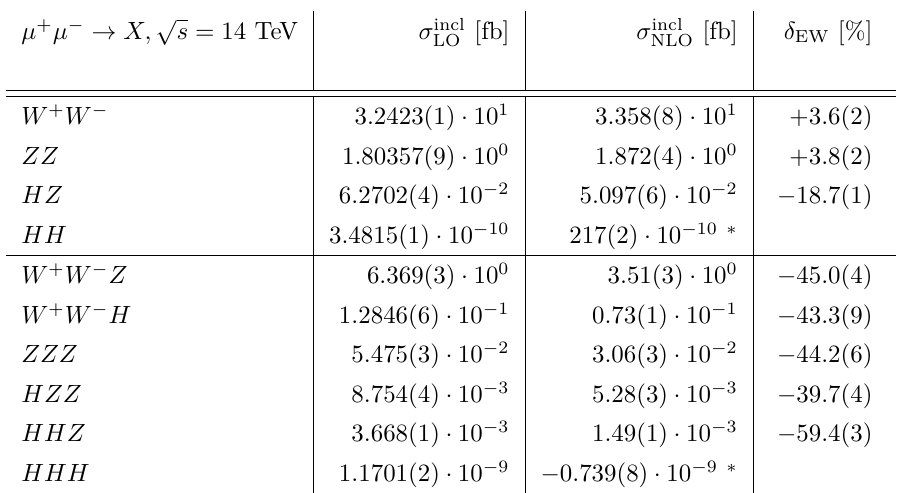
Table 3 . Total inclusive cross sections at LO and NLO with corresponding relative correction δ EW √ for di- and tri-boson production at s = 14 TeV. For (*), with dominant loop-induced contributions, we refer to remarks in the